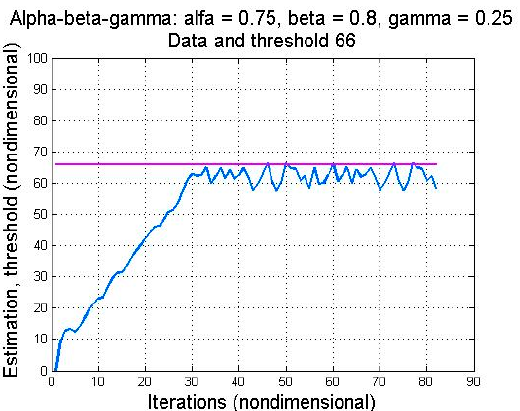
Figure 12. The α – β – γ filter successfully provides an estimate that exceeds the threshold value of 66.